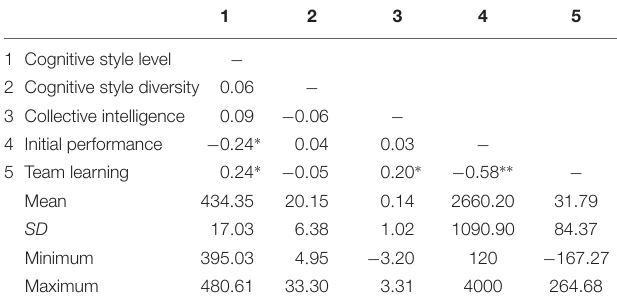
TABLE 1 | Team means and intercorrelations between cognitive style diversity, collective intelligence, and learning.